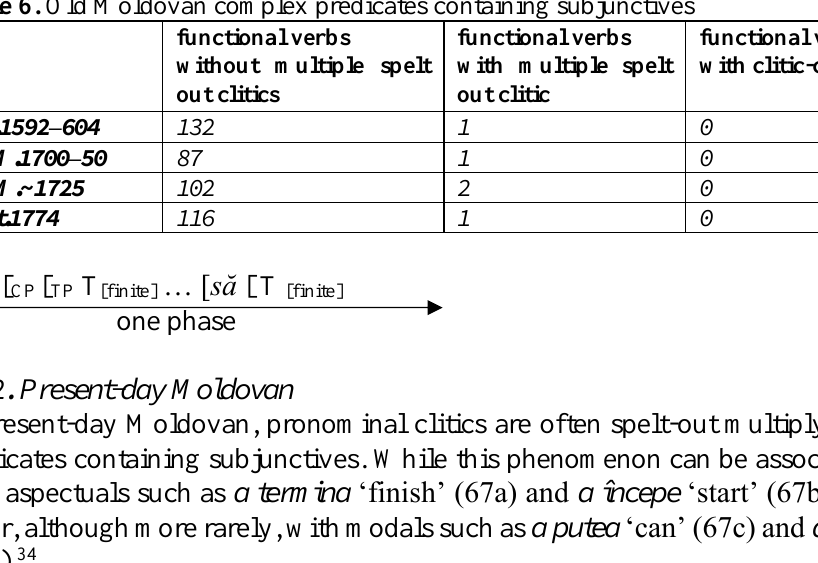
functional verbs with multiple spelt out clitic 1 0